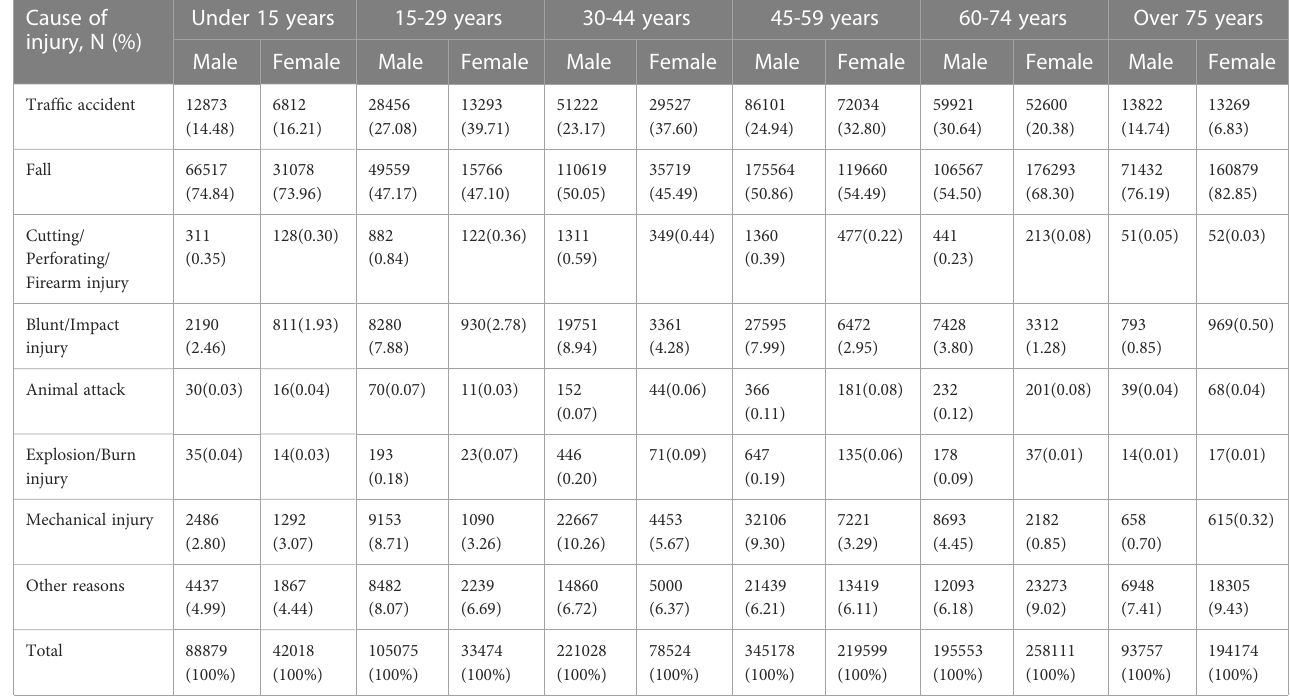
TABLE 2 Age and gender-strati fi ed overview of causes of traumatic